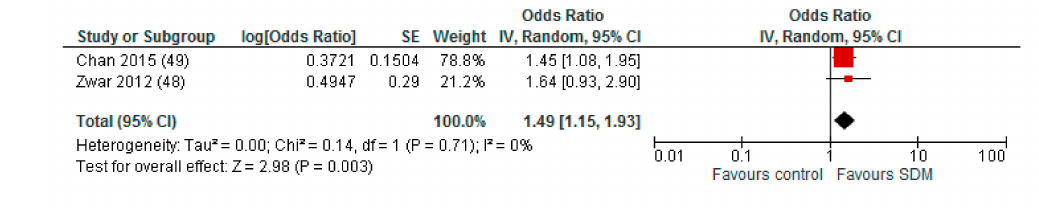
Figure A2. Subgroup: Deliberation by